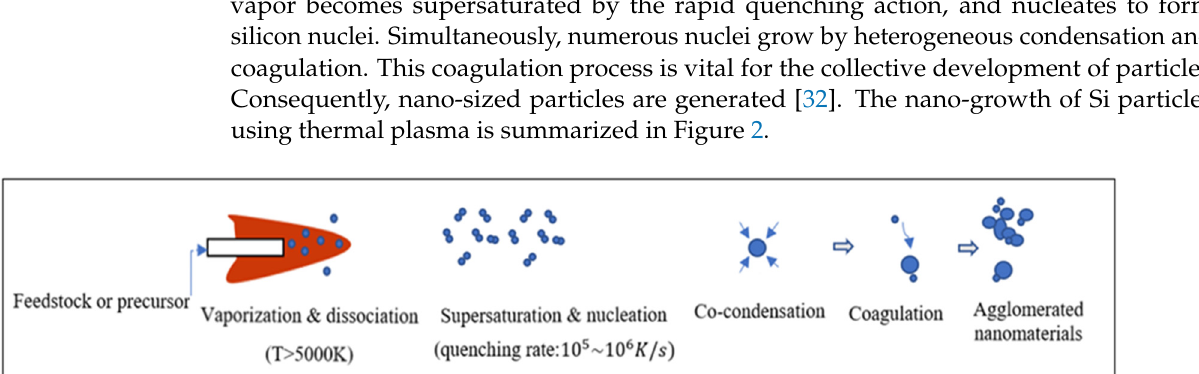
Figure 2. Principle of nanoparticles generation by thermal plasma.